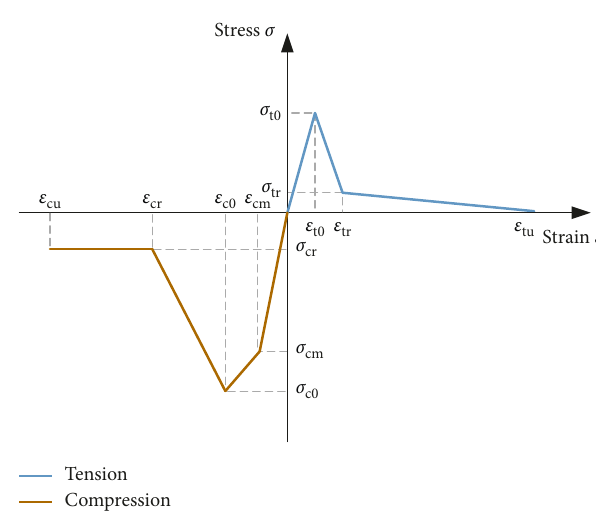
Figure 11: Nonlinear constitutive model for